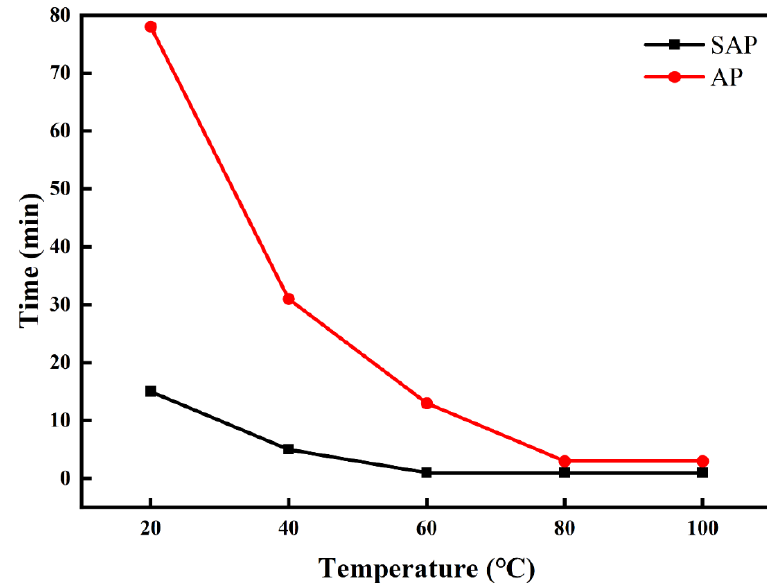
Figure 4. Solubility of AP and SAP.